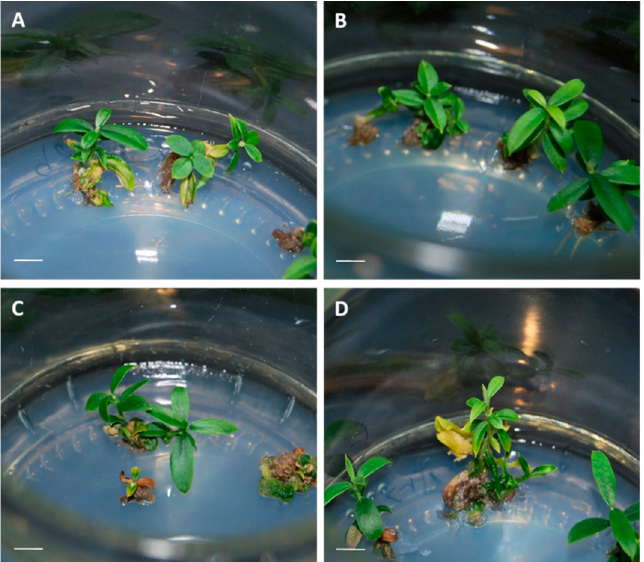
Figure 8. Germination of olive somatic embryos developed from control ( A , C ) and cryopreserved ( B , D ) cultures of the lines T1 ( A , B ) and P5 ( C , D ). Bar = 1 cm. Table 3. Germination percentages of somatic embryos developed from control and cryopreserved embryogenic cultures of the lines Table 1. and P5. Data assessed after two six-week recultures in the germination. Different letters indicate sig- nificant differences by the R × C test of independence with a significance level of 0.05. Embryogenic Line